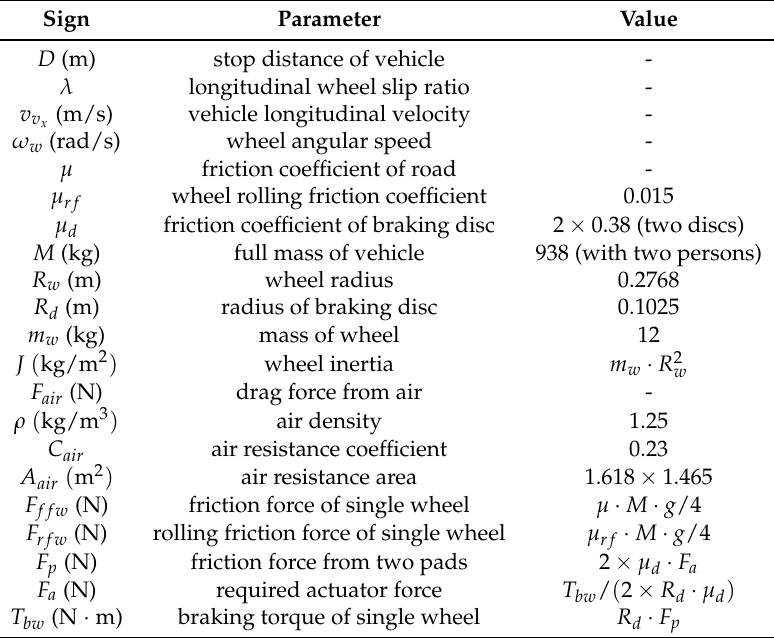
Table A1. Variables and parameters of SMWSC for BYD